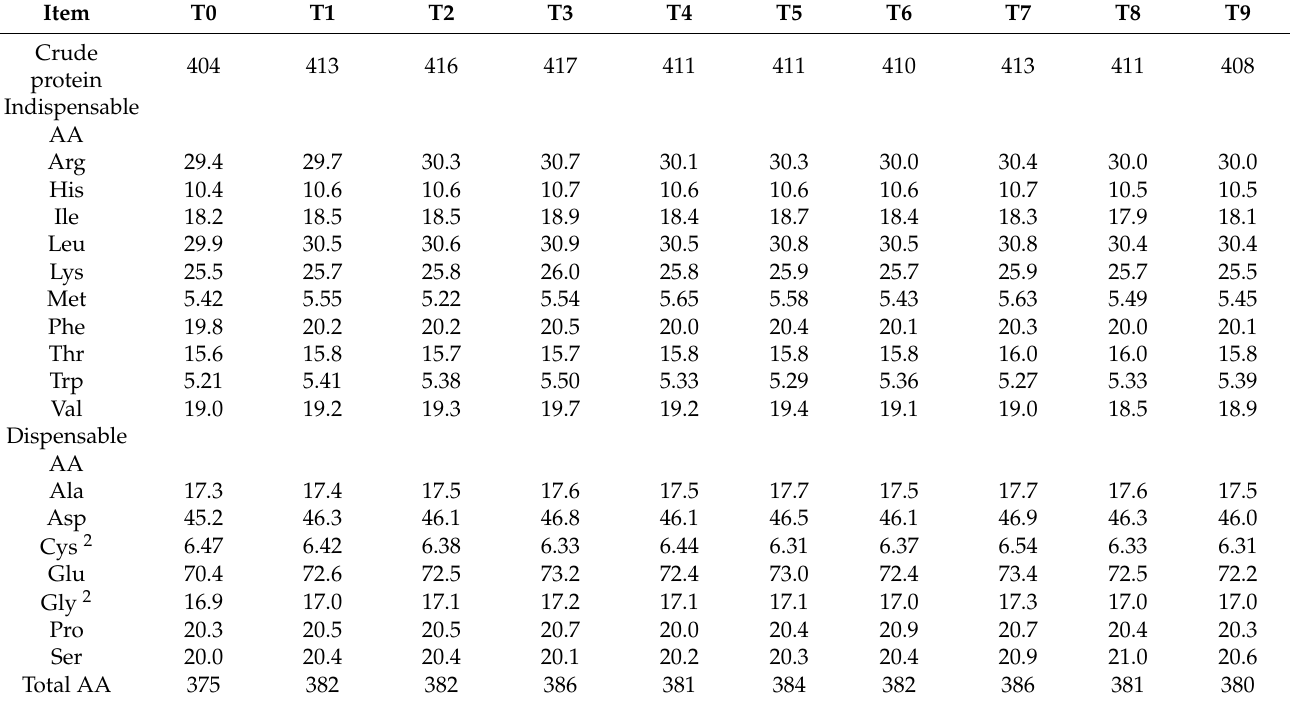
Table 5. Analyzed amino acid (AA) contents (g/kg, dry matter basis) of differently heat-treated full-fat soybeans 1